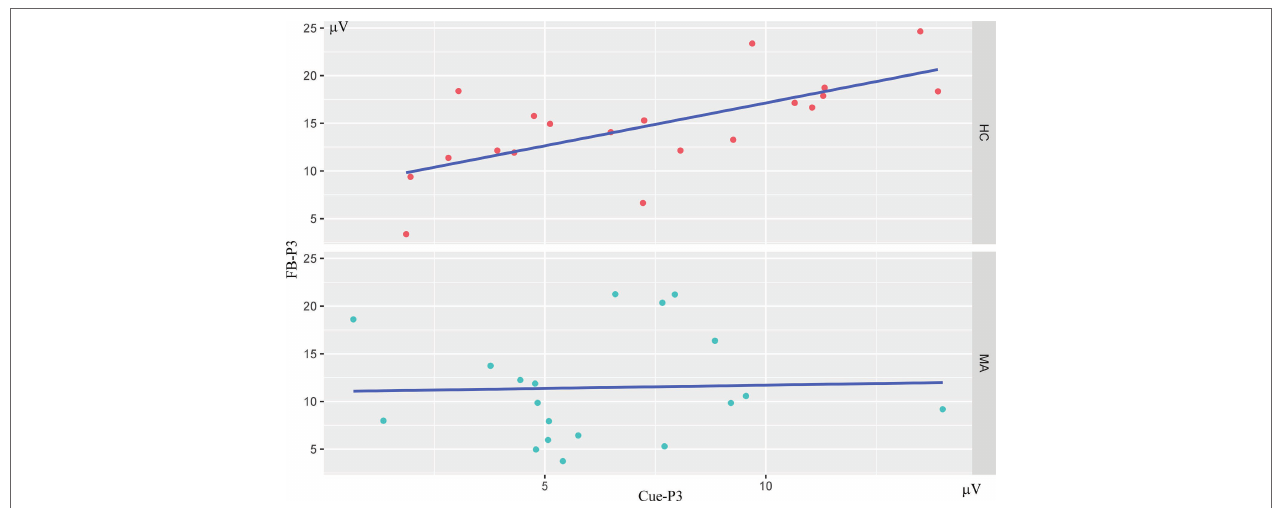
FIGURE 5 | Scatterplots depicting the bivariate correlations for Cue-P3/FB-P3 in HC ( N = 20) and MA ( N = 19) groups. Correlations were calculated using amplitude of ERPs in social incentives condition (FB-P3 averaged for feedback).